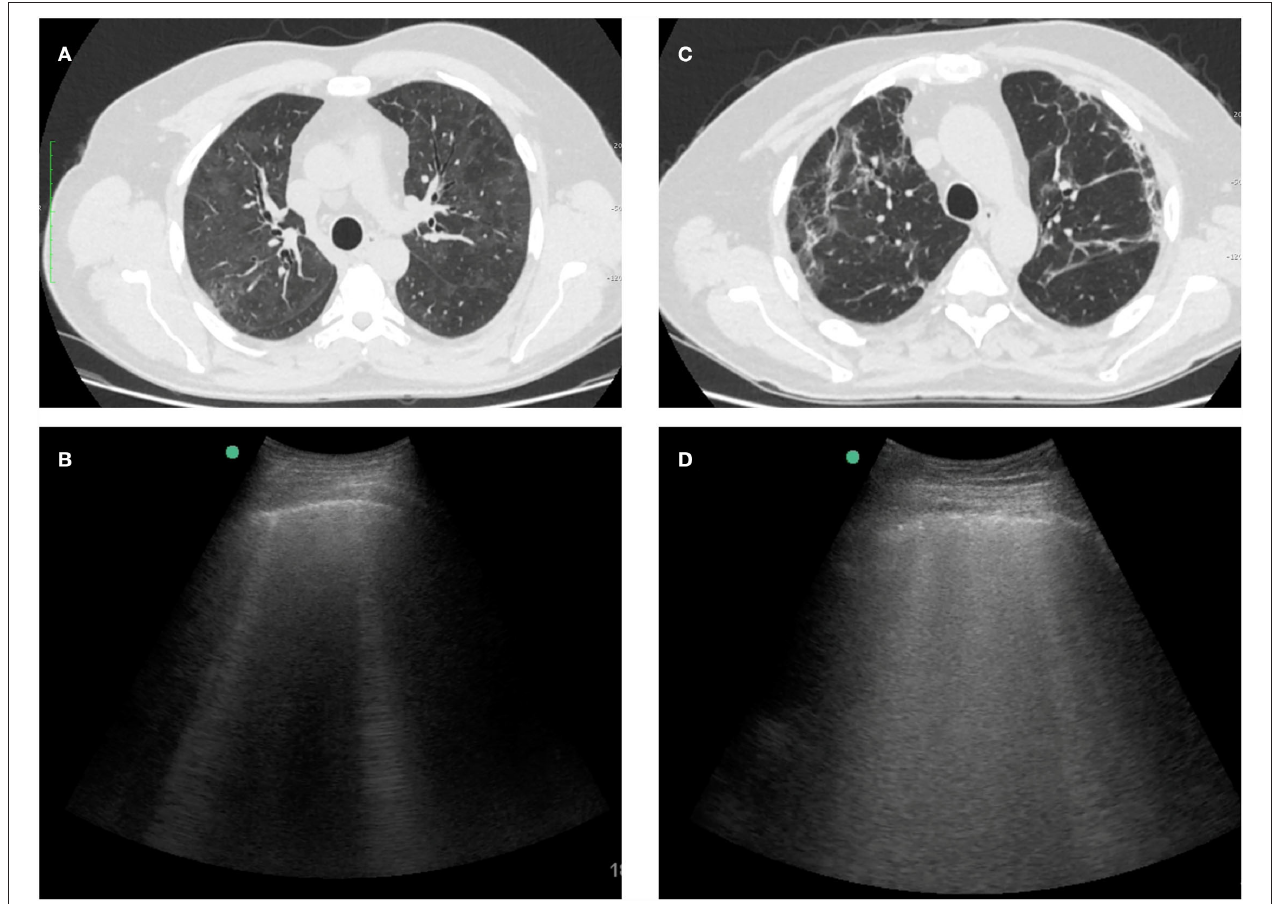
FIGURE 2 | Examples of HRCT and LUS images from 2 patients with interstitial lung sequelae after COVID-19. (A) Persistent diffuse ground-glass opacities on HRCT. (B) LUS of the same patient with isolated B-lines and absence of pleural line abnormalities. (C) Subpleural lines and parenchymal bands on HRCT. (D) LUS of the same patient with confluent B-lines and blurred pleural